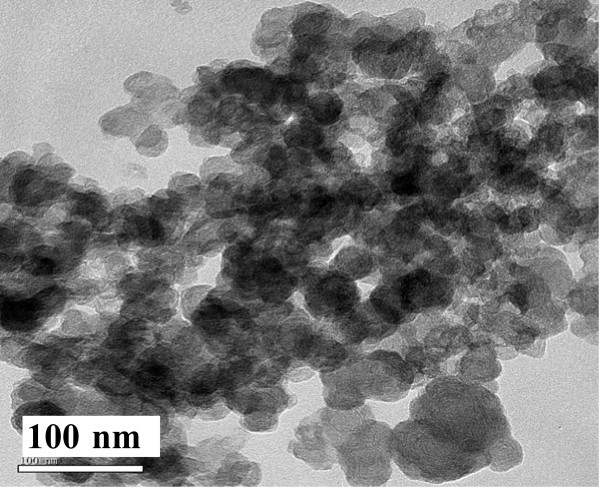
TEM image of the solid sample prepared with 9 mL 0.06 M Na3cit aqueous solution.